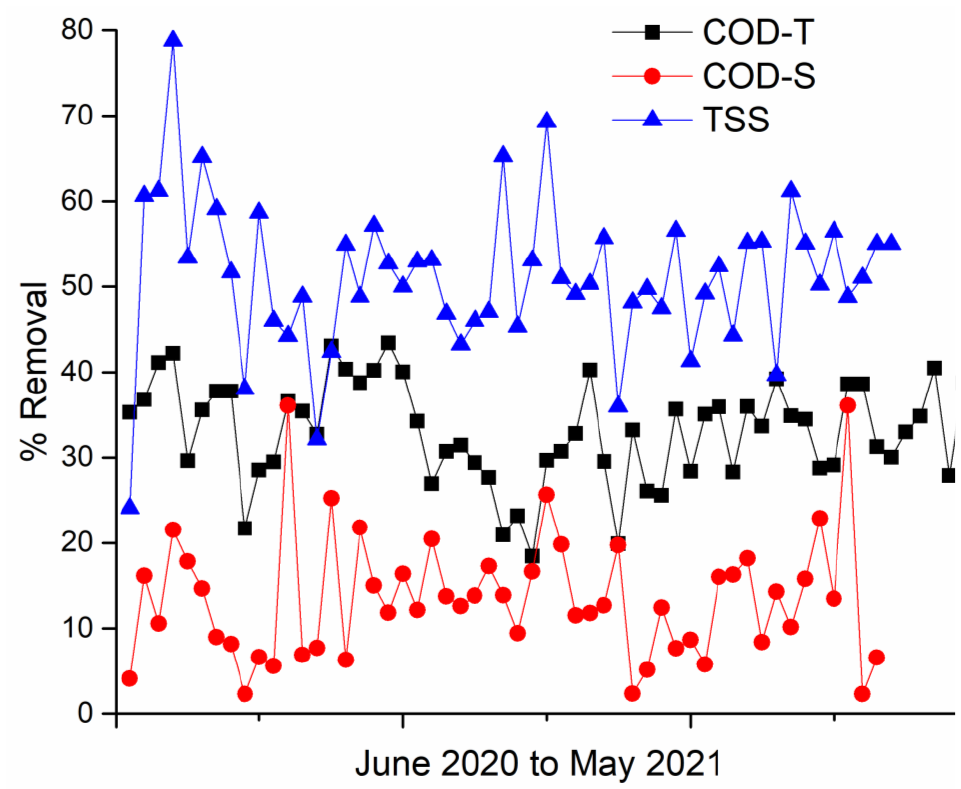
Figure 2. Removal efficiency of COD-T, COD-S and TSS in pilot-scale BEPT process. Table 1. Performance comparison of pilot-scale BEPT process and conventional primary treatment of wastewater.